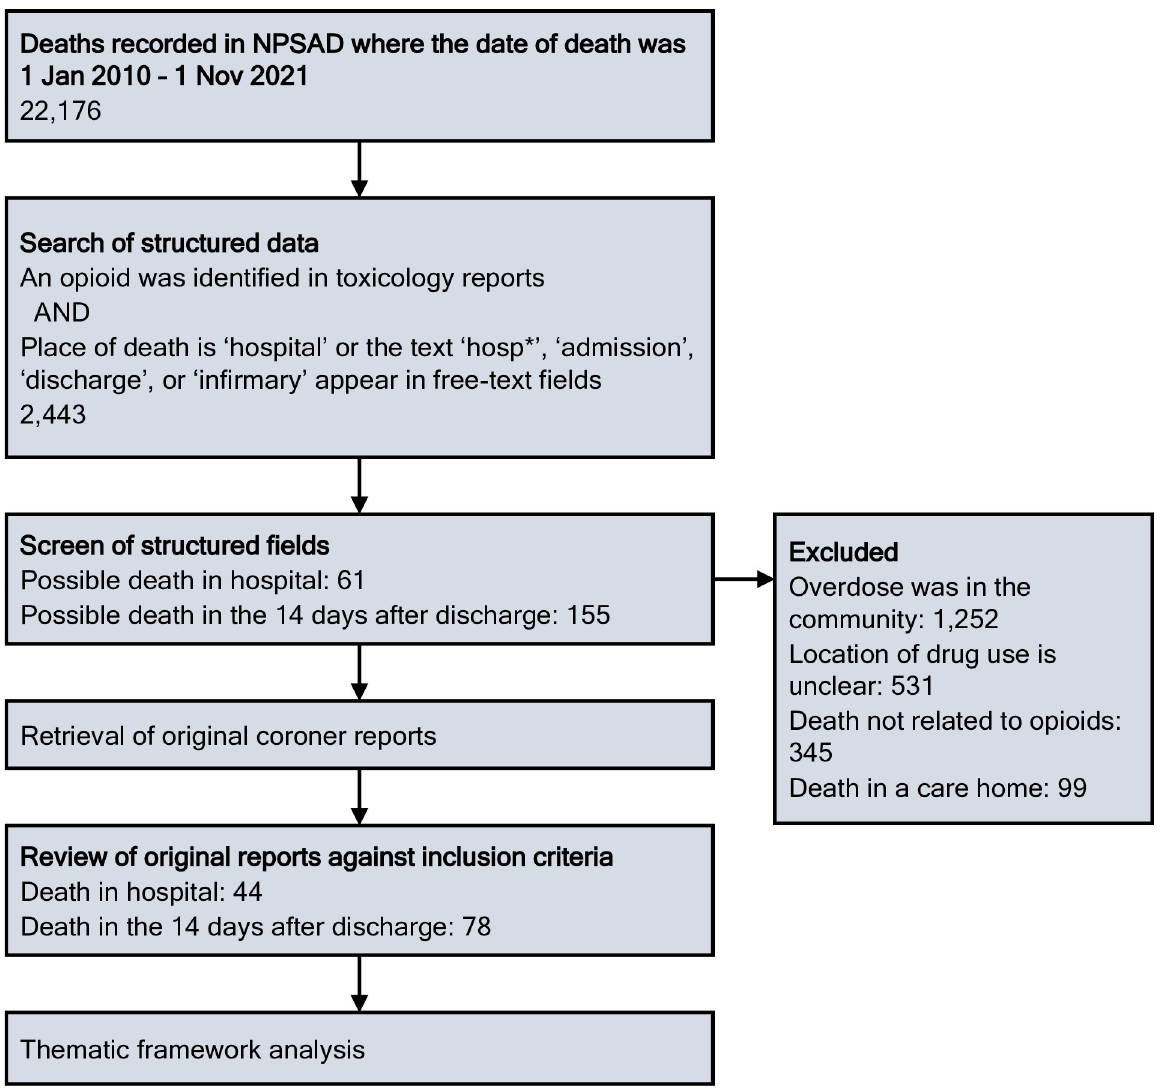
Fig 1. Flow chart of the process of selecting coroner reports for analysis. NPSAD = National Programme on Substance Abuse